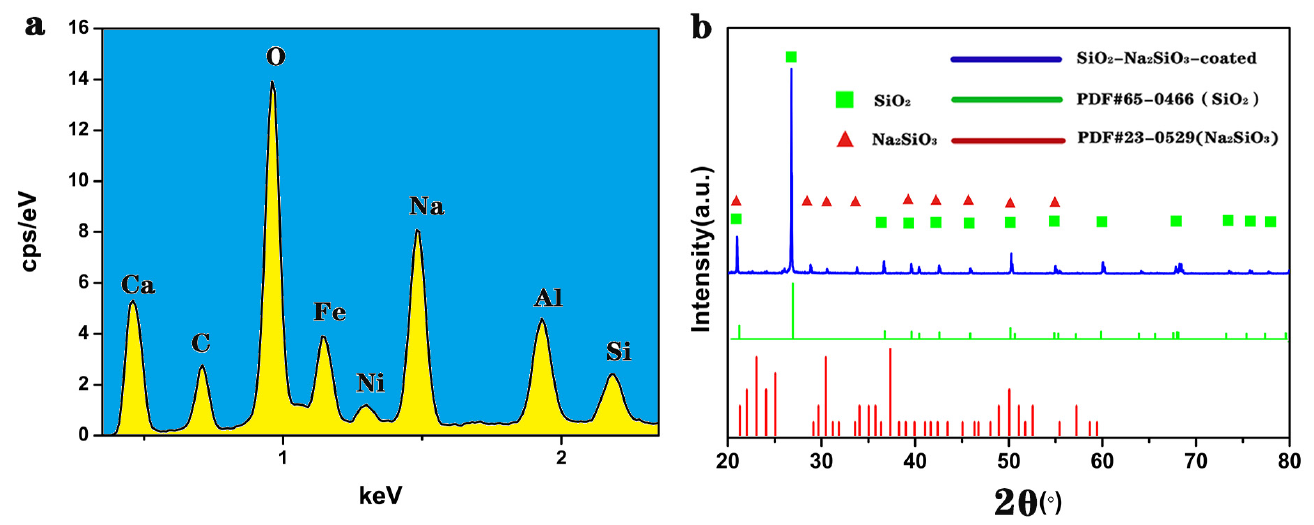
Figure 2. ( a ) EDS spectrum of the SiO 2 -Na 2 SiO 3 -coated SSF and ( b ) the XRD diffraction patterns.